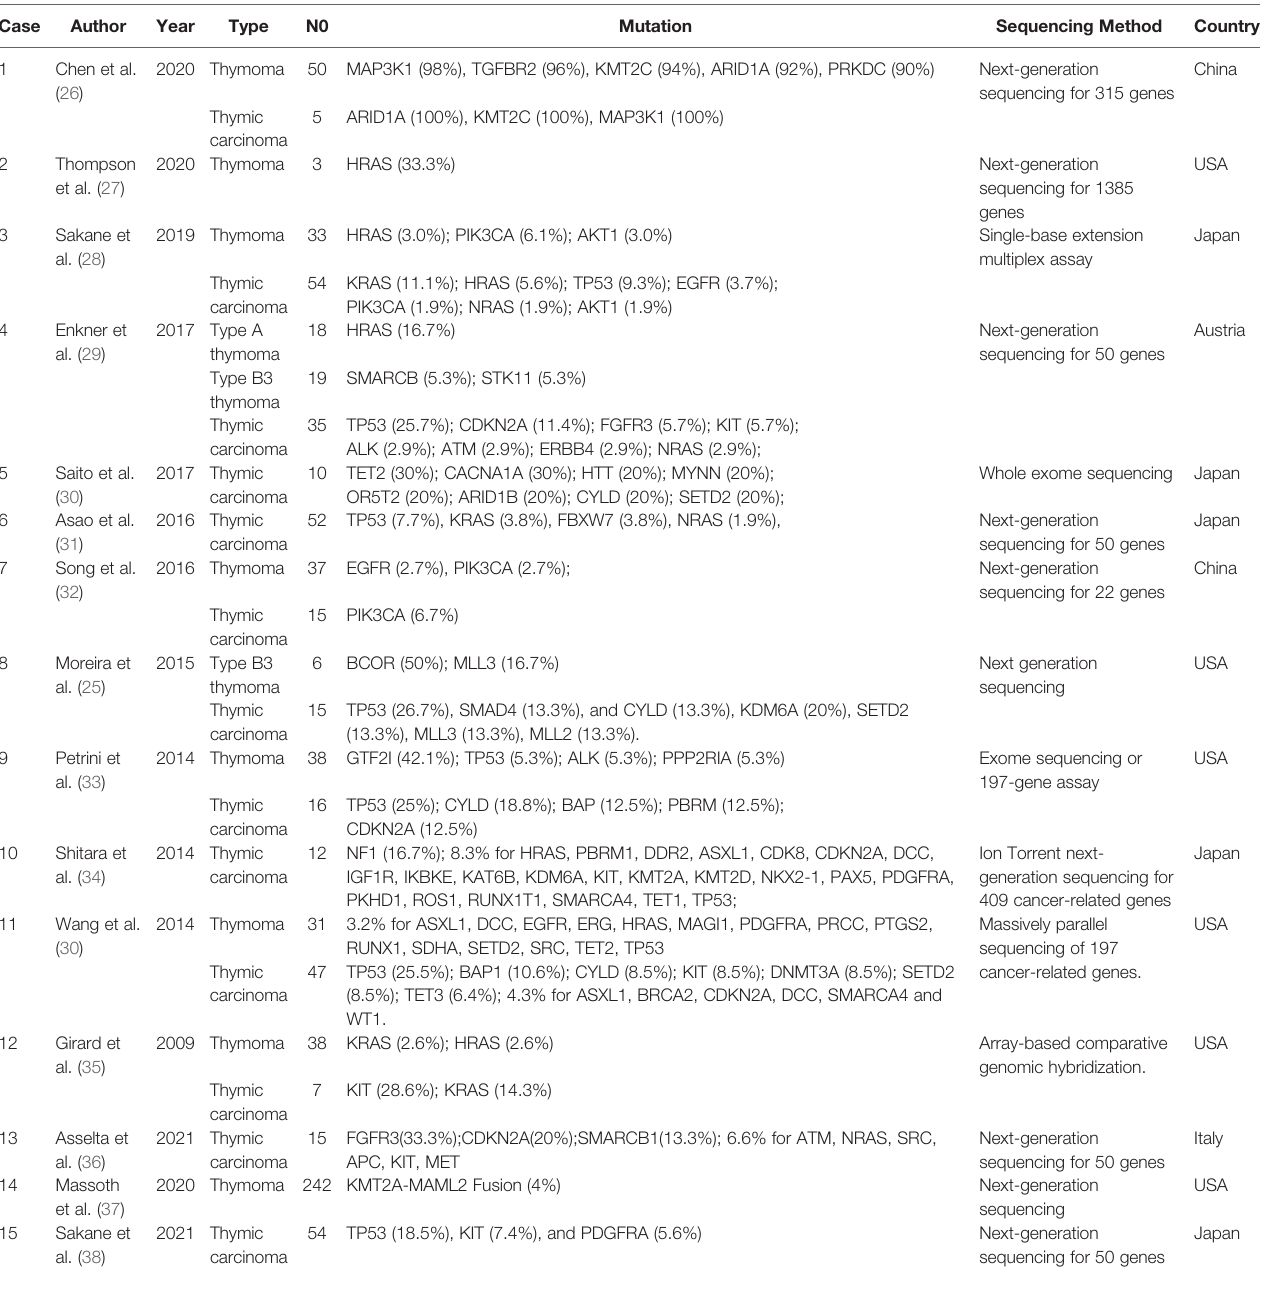
TABLE 4 | Gene mutation analysis of TETs from previously published